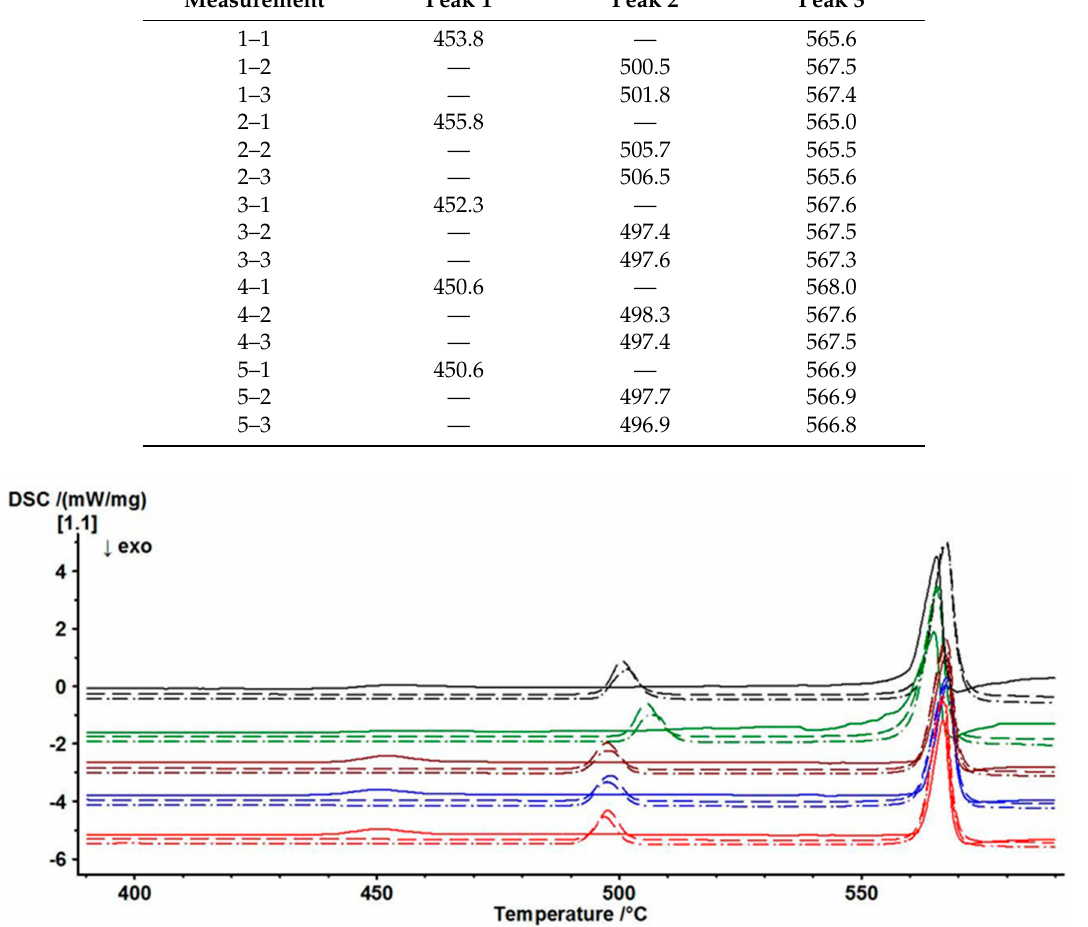
Figure 8. Differential scanning calorimetry (DSC) results for five independent measurements of γ -PbTeO 3 including three heatings and coolings each (only heating curves are shown: first heating closed lines, second heating dashed lines, third heating dashed-dotted